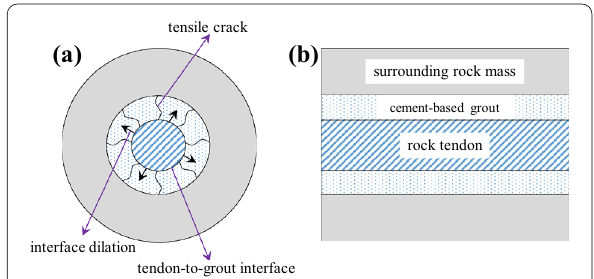
Fig. 1 Rock reinforcement system a cross-sectional view; b lateral